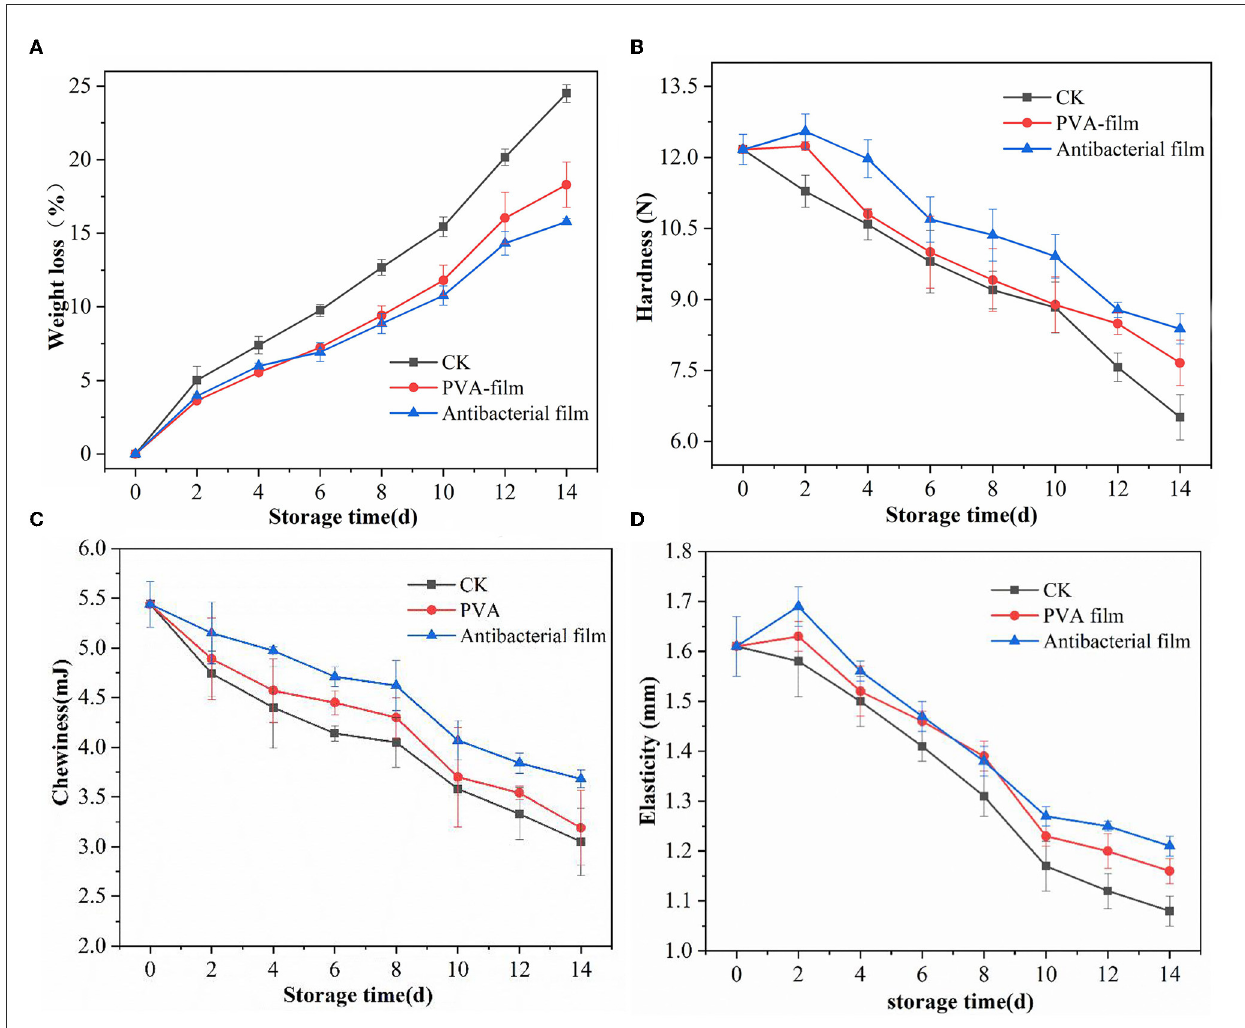
FIGURE4 Water weight loss rate of blueberries in each group during storage (A) , hardness changes of blueberries in different groups during storage (B) , changes in chewiness of blueberries in each group during storage (C) , and elasticity of blueberries in different groups during storage (D)